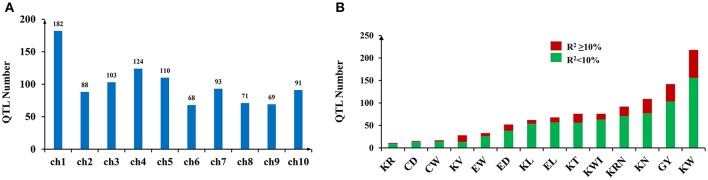
QTL numbers and associated R2-values (variance explained by a single QTL) distributed across the entire genome. (A) QTL numbers distributed on each chromosome. (B) The variance explained by a single QTL in the traits included in this study.